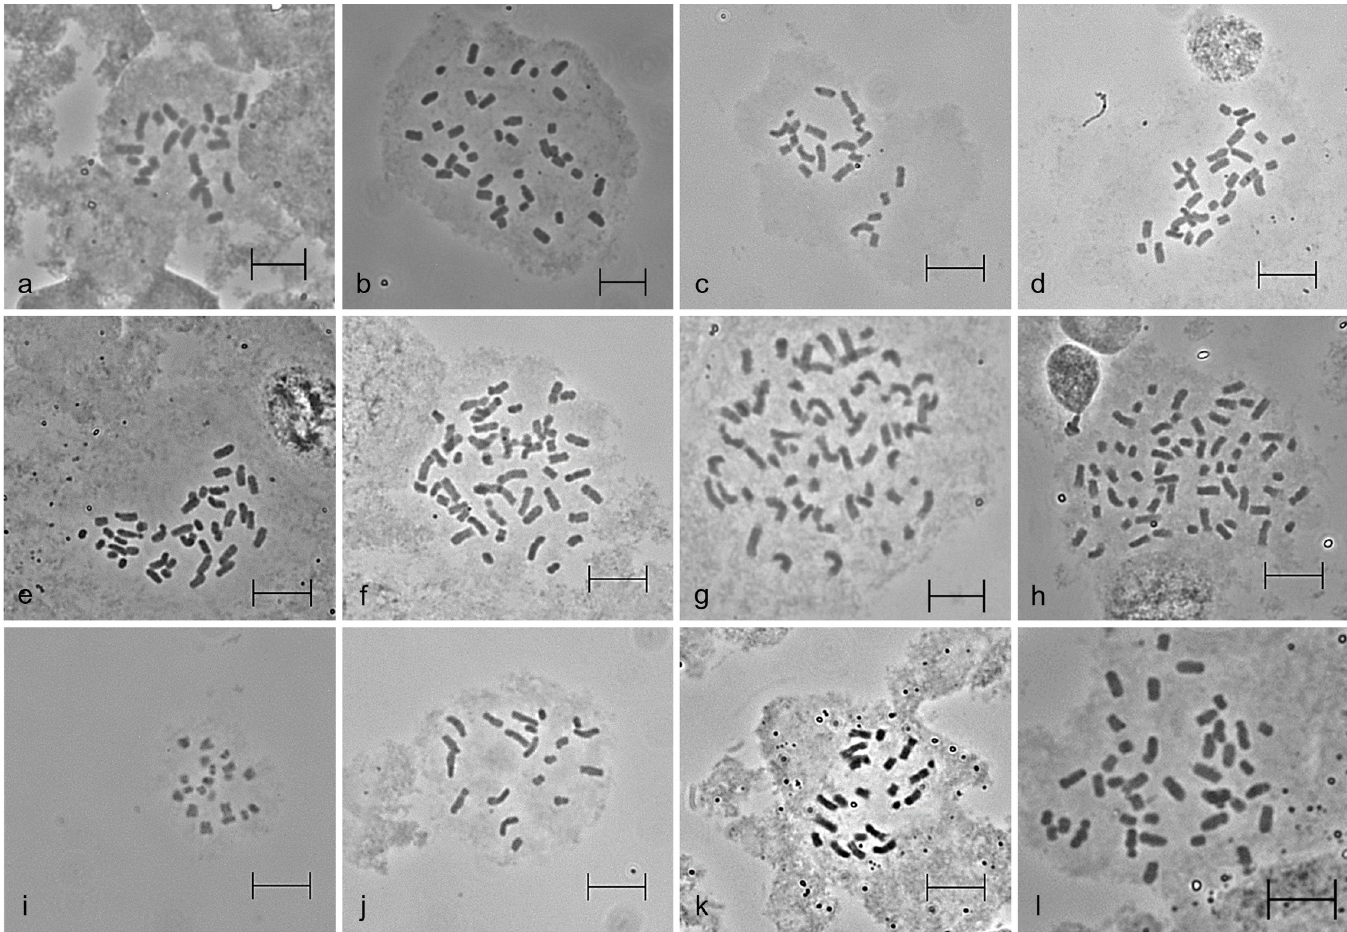
Fig 1. Mitotic metaphase chromosomes in root tip cells. a) A . officinalis ‘Darlise’ (2n = 2x = 20); b) A . officinalis ‘Steiners Violetta’ (2n = 4x = 40); c) A . albus (2n = 2x = 20); d) A . albus (2n = 3x = 30); e) A . prostratus 4 (2n = 4x = 40); f) A . amarus (2n = 5x = 50); g) A . amarus (2n = 6x = 60); h) A . maritimus 4 (2n = 6x = 60); i) A .